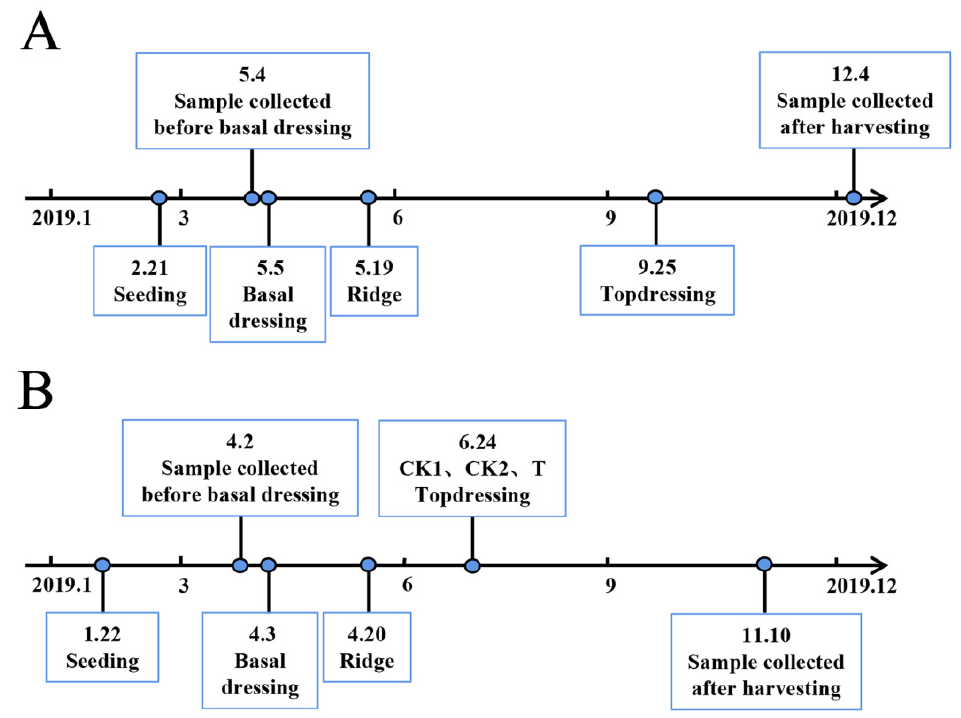
Figure 2. Time flow chart of the taro field management and sampling. ( A ) Wheat straw mulching experiment. ( B ) Rice straw mulching experiment.